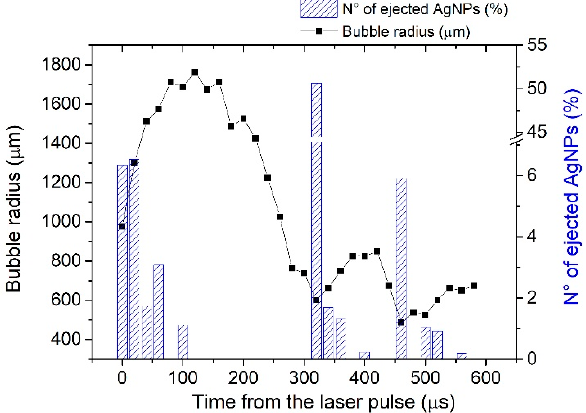
Figure 7. Time-resolved shadowgraph images of the laser-induced bubble on Ag target immersed in water. (Laser pulse width = 6 ns, laser energy = 50 mJ, laser wavelength = 532 nm, laser frequency = 2 Hz, crater sizes = 1 ± 0.2 mm, ICCD gate width = 20 μ s, 5 accumulations for each image) .